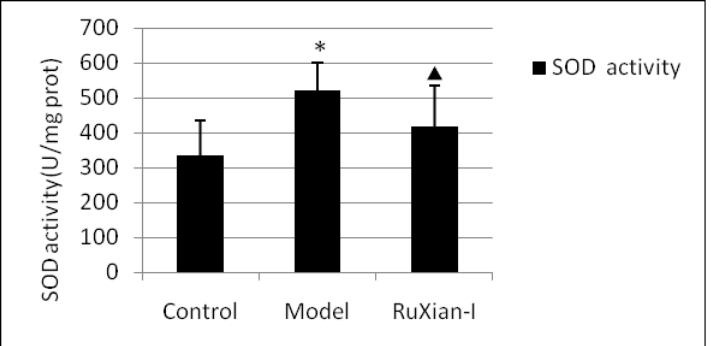
Figure 5. SOD activity assayed with commercial kits in rat breast tissue homogenate in various